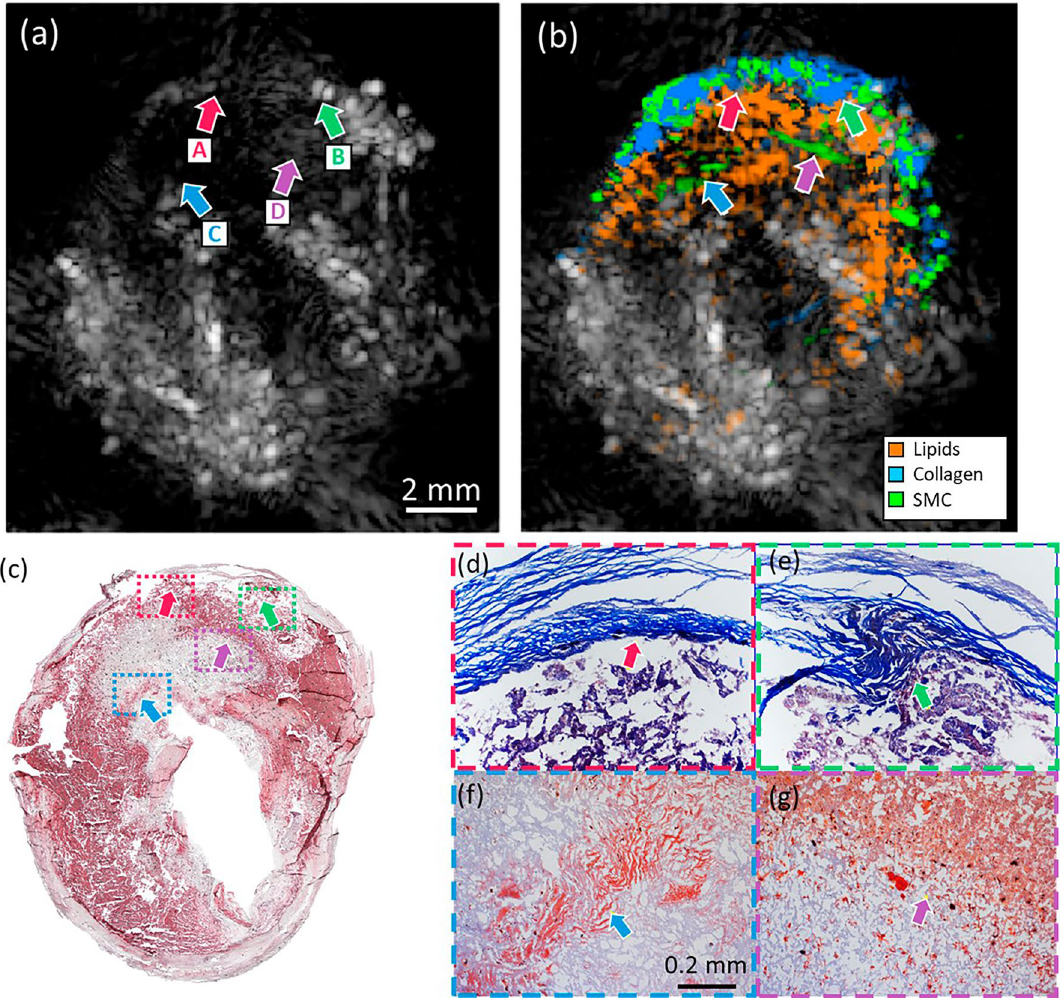
Figure 5. Endarterectomy plaque with a large necrotic area. ( a , b ) are the US and proportion maps for collagen, lipids, and SMC using selected wavelengths. ( c ) is the ORO staining of the plaque, where the red area indicates the presence of lipids. ( d , e ) are MT stains (magnification × 100), where the blue areas correspond to collagen; and arrows A and B point at geometrical features that are distinguishable in both histology and spectral unmixing map. ( f , g ) are ORO stains (magnification × 100), and arrows C and D point at the interfaces between lipid and lipid-free areas, observable in the unmixing proportions